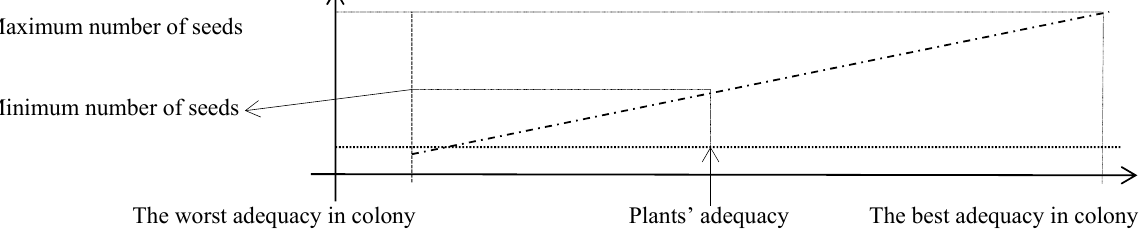
Fig. 1. Procedure to calculate the quantity of seeds produced by each